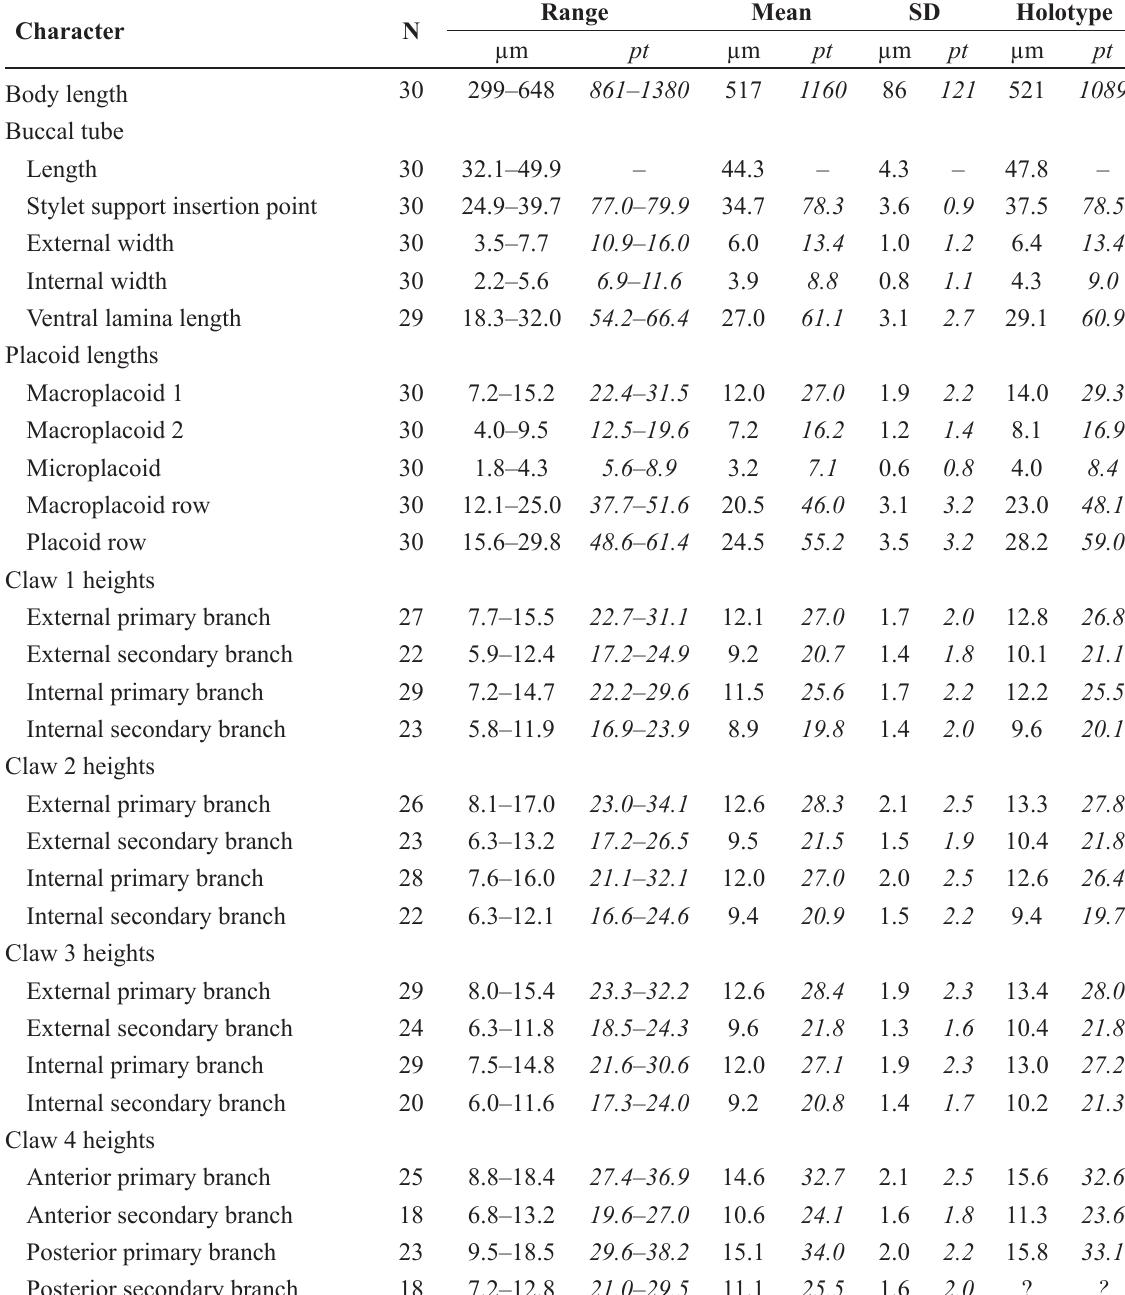
Table 2. Measurements (in μm) and pt values of selected morphological structures of the holotype and paratypes of Macrobiotus engbergi sp. nov. mounted in Hoyer’s medium. (N: number of specimens/ structures measured, RANGE refers to the smallest and the largest structure among all measured specimens; SD: standard